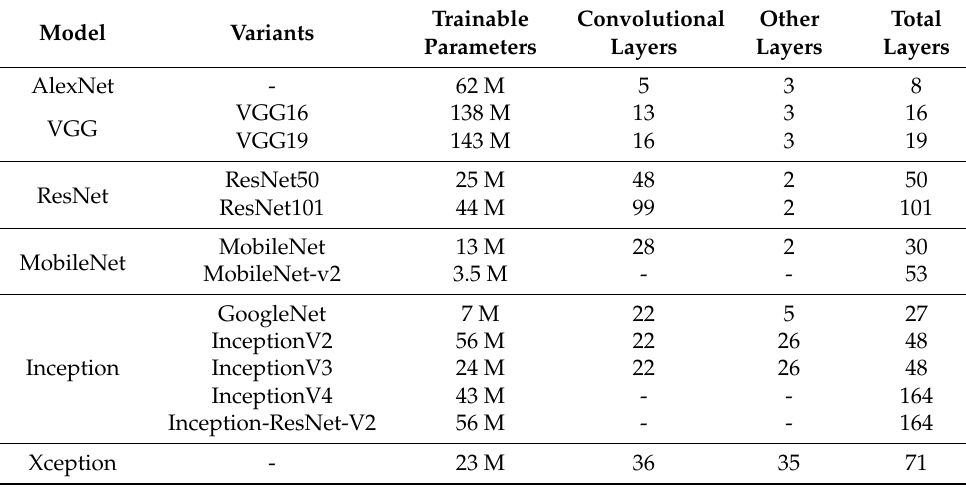
Table 1. A summary of pre-trained CNN-based